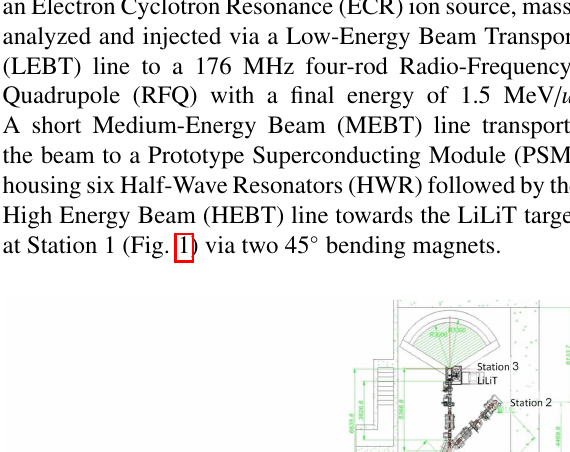
Figure 2. (top) Photographs of the liquid-lithium flow taken with an optical camera; (bottom) a beam-on beam-o ff subtracted IR image of the lithium flow. The figure is adapted from [8].